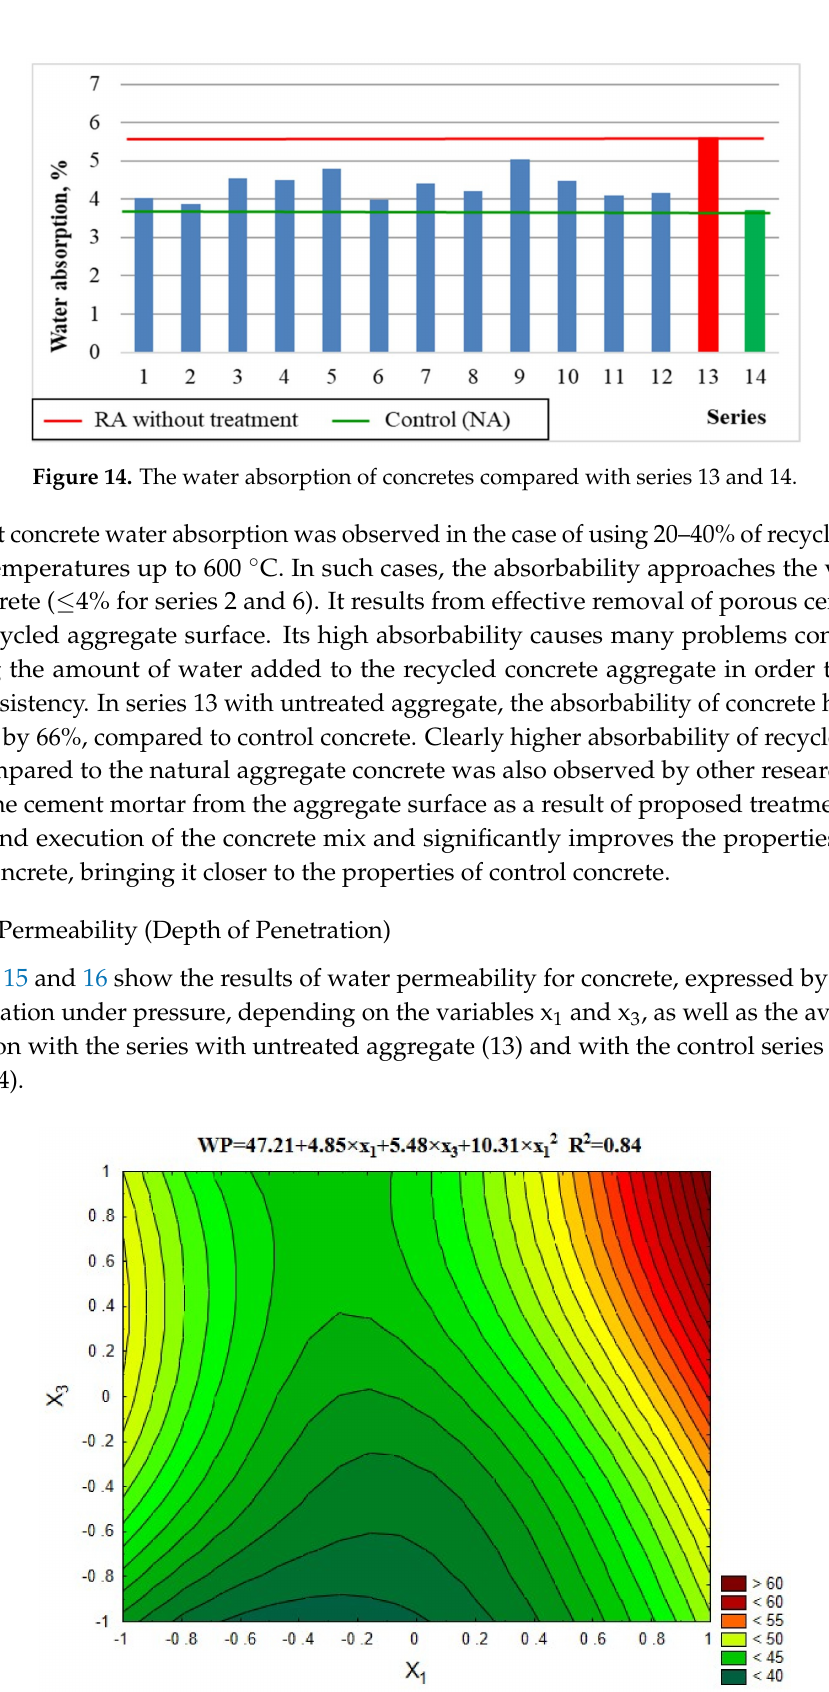
Figure 15. The changes in the depth of water penetration depending on x 1 and x 3 (x 2 =